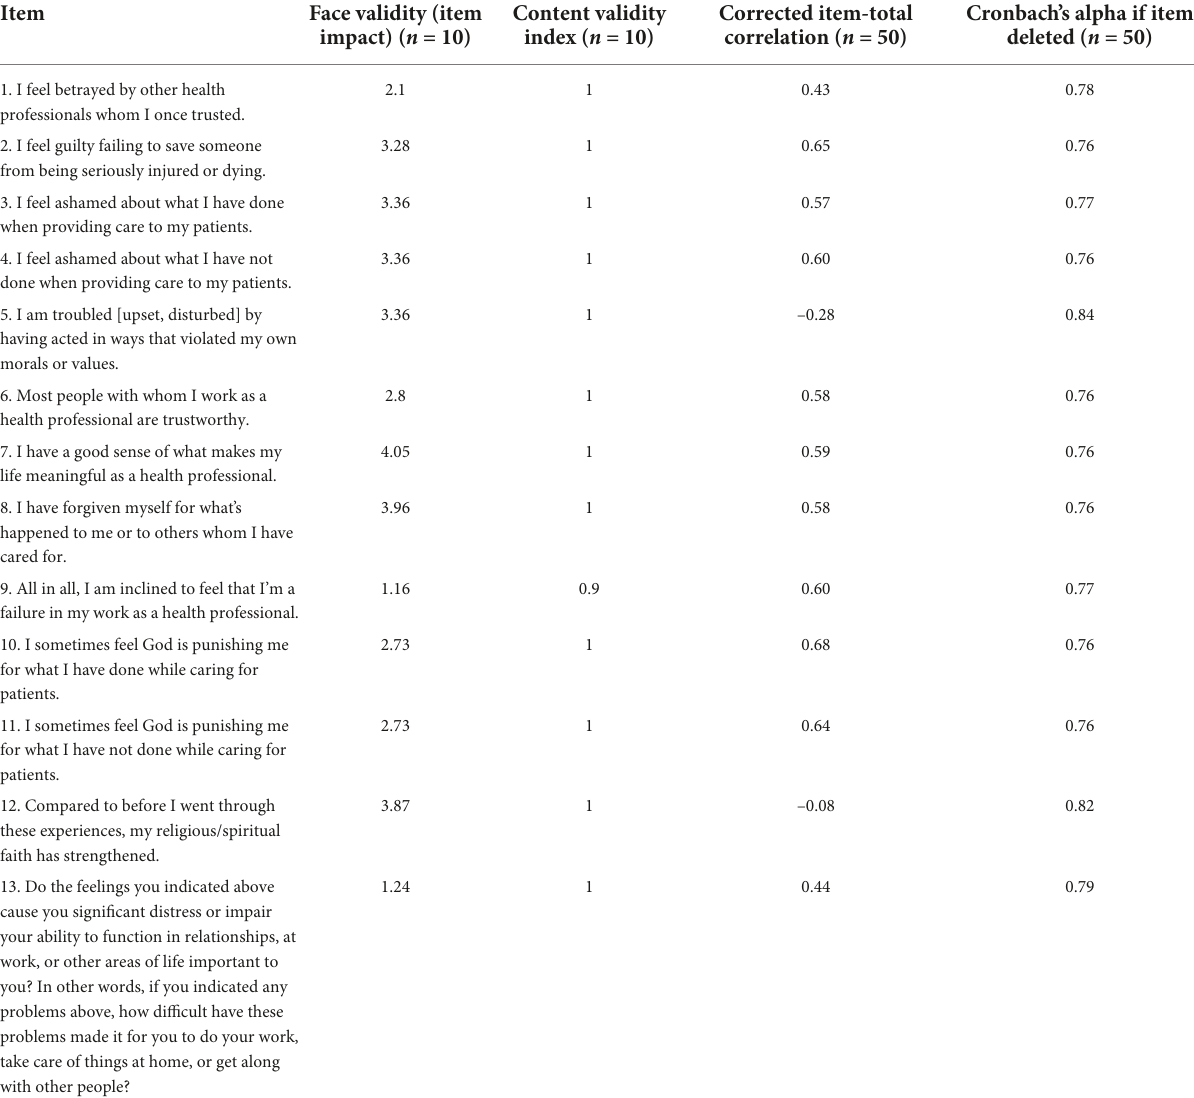
TABLE 1 Face and content validities and internal consistency of the Persian Version of the Moral Injury Symptoms Scale-Health Care Professionals Version.